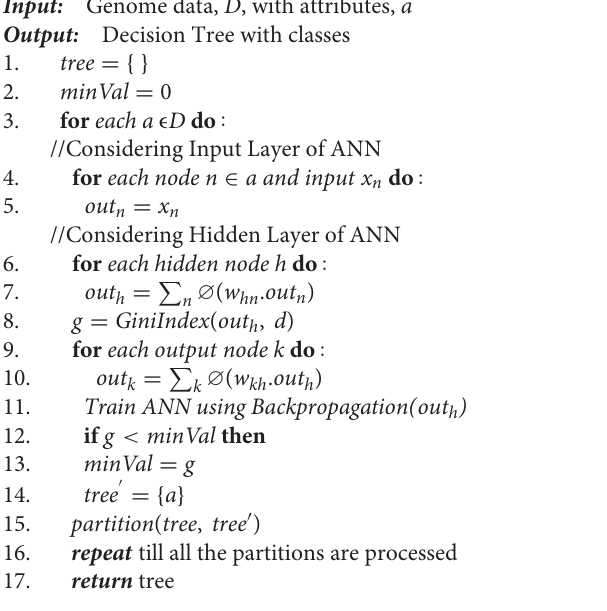
Algorithm 1 Proposed